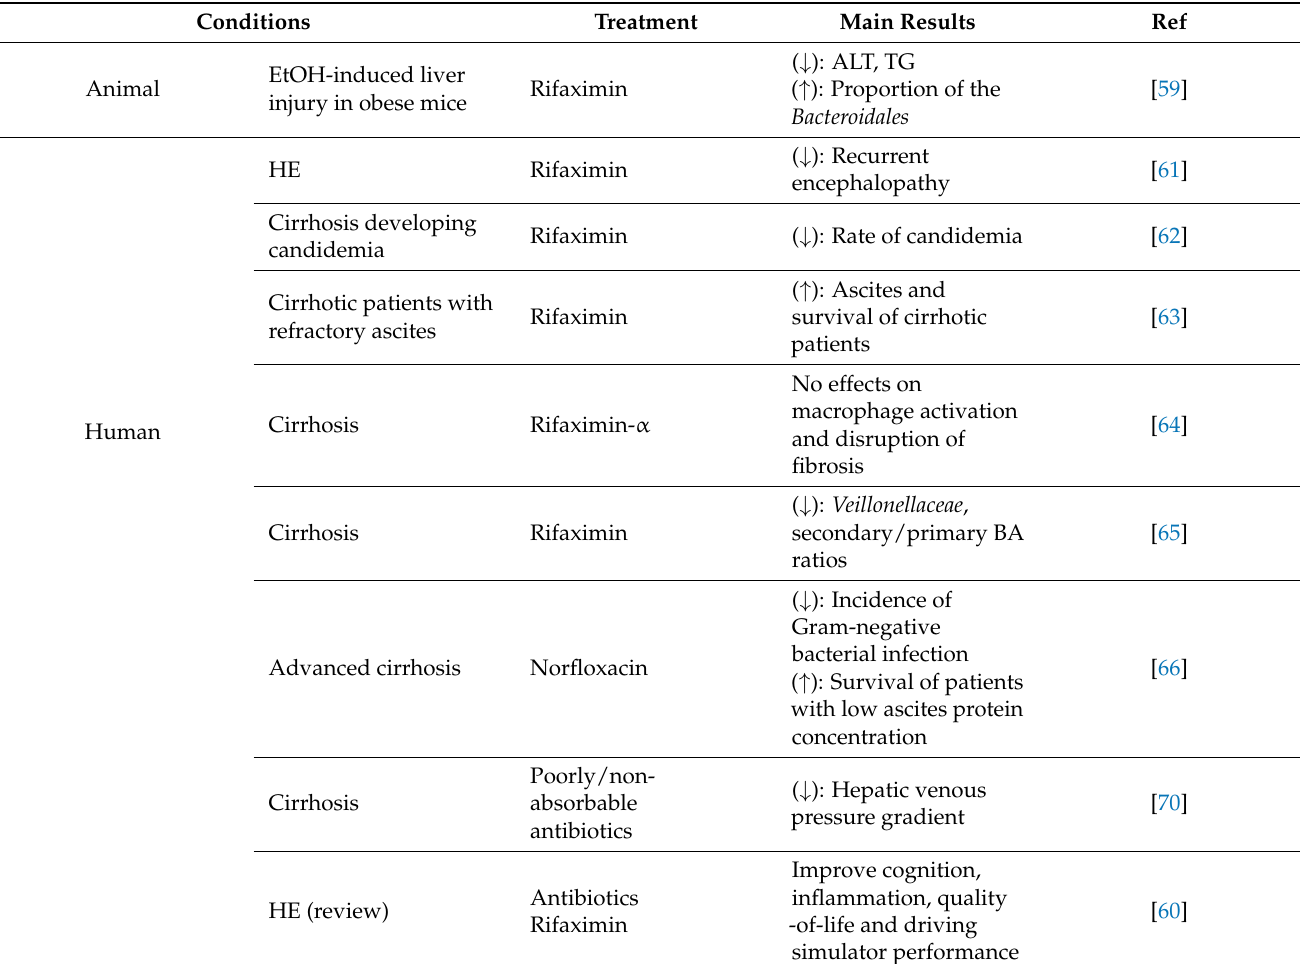
Table 1. Animal and human studies using